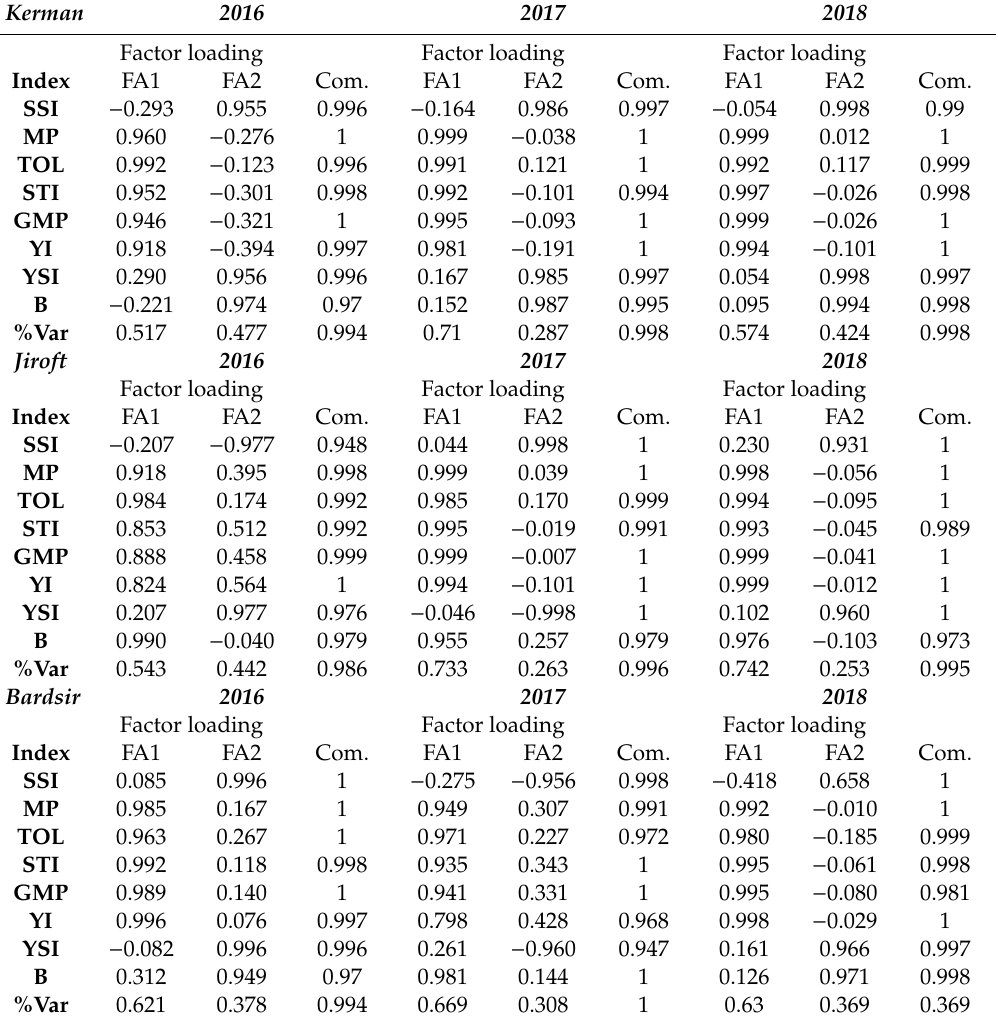
Table 7. Factor analysis (FA) for drought tolerance / susceptibility indices of genotypes in Kerman, Jiroft, and Bardsir in three